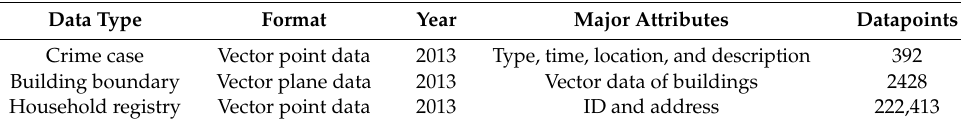
Table 1. Data collected for crime prediction.